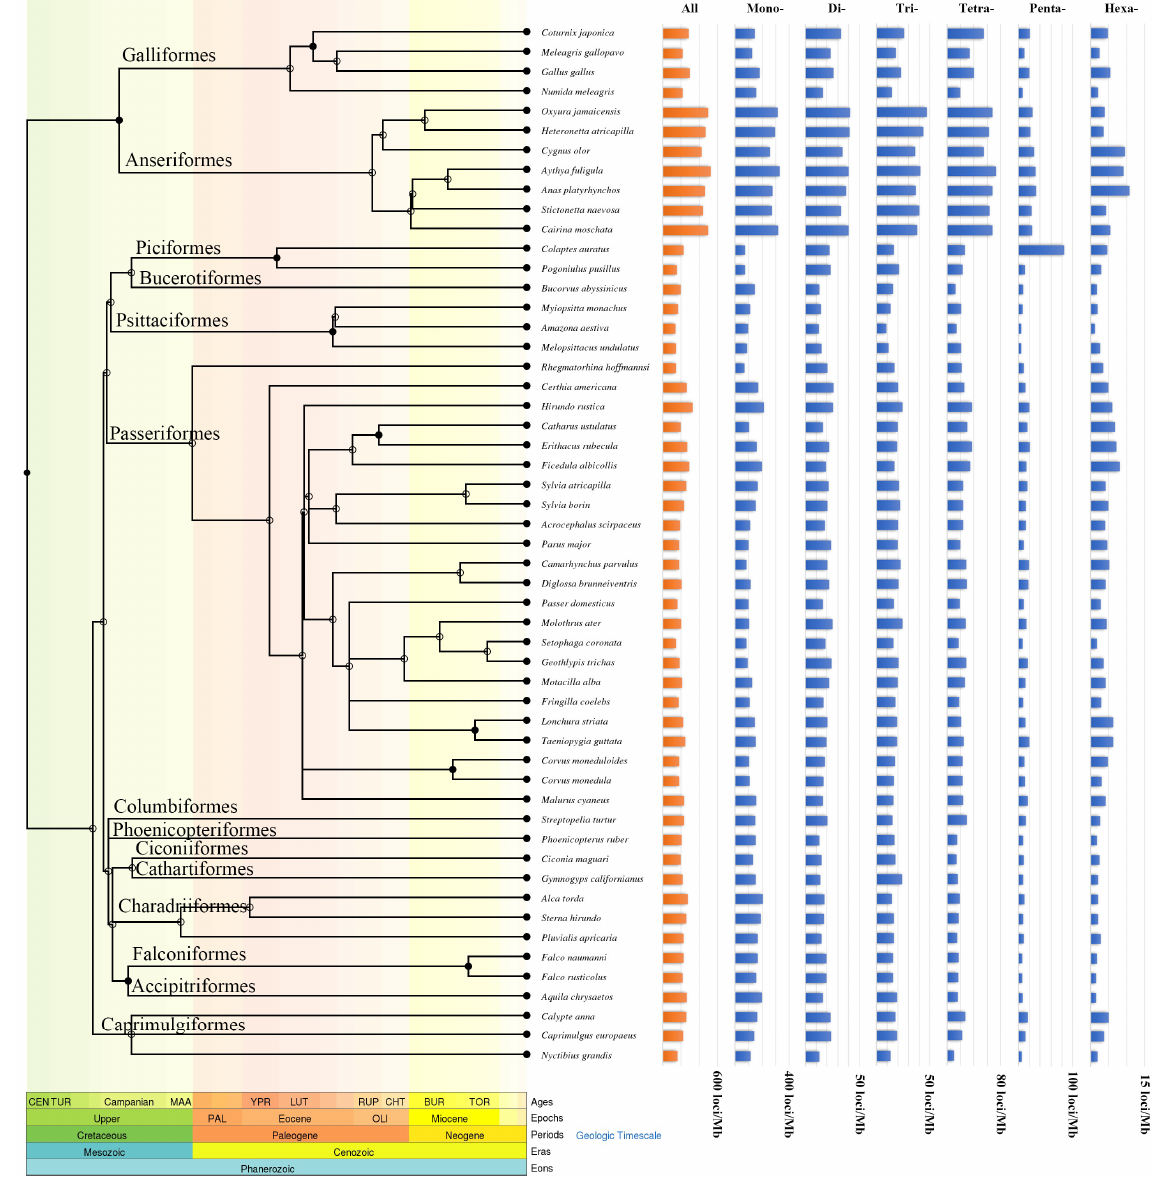
Figure 2. The abundance of P-SSRs.